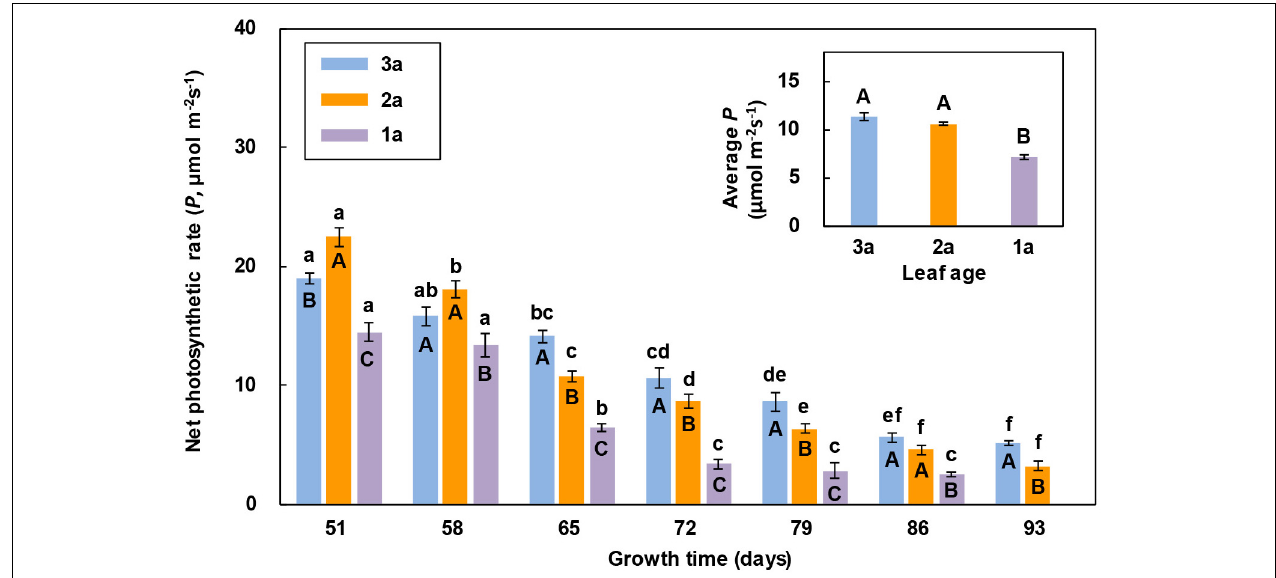
FIGURE 2 | Comparison of the net photosynthetic rate ( P ) of three leaves of reproductive ramets over time (means ± SE, n = 10) in Leymus chinensis . Different lowercase letters indicate significant differences ( P < 0.05) between the growth times for the same leaf age; different capital letters indicate significant differences ( P < 0.05) between the leaf ages for the same growth time. The average P of seven growth times is presented as an inset figure. The dates corresponding to the seven growth times are May 26, June 2, June 9, June 16, June 23, June 30, and July 7 in 2017.